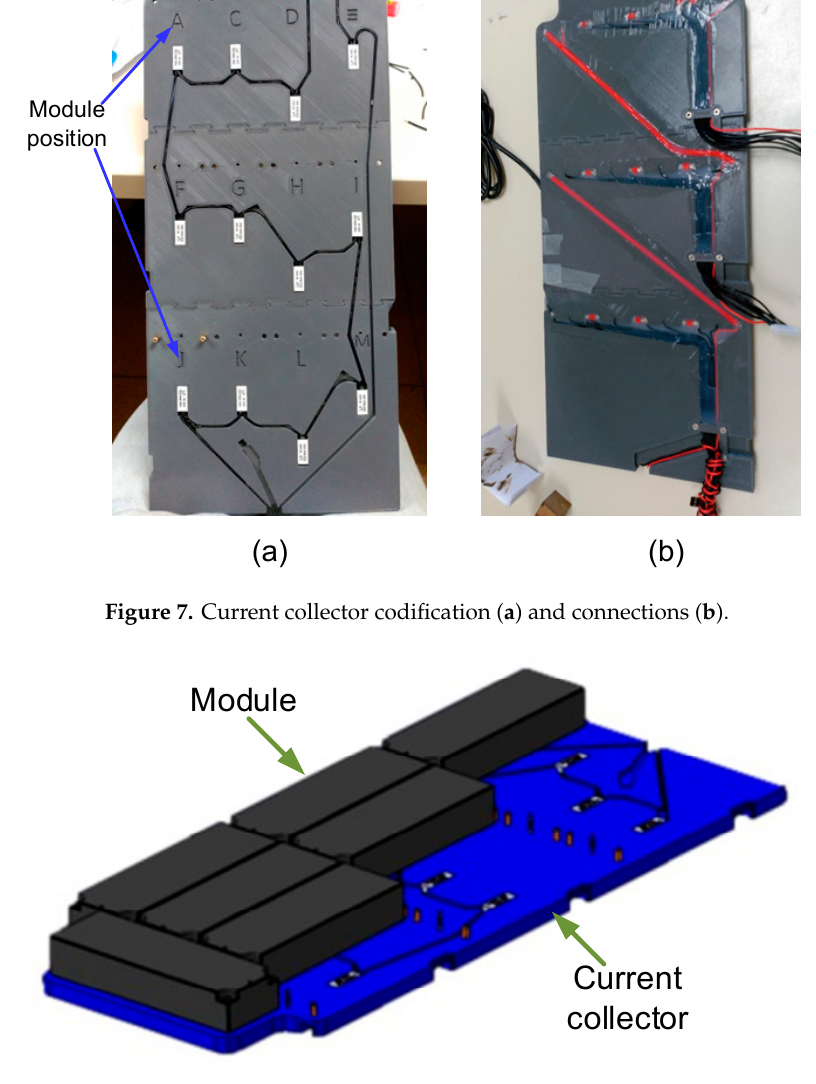
Figure 9. Example of parallel connection.